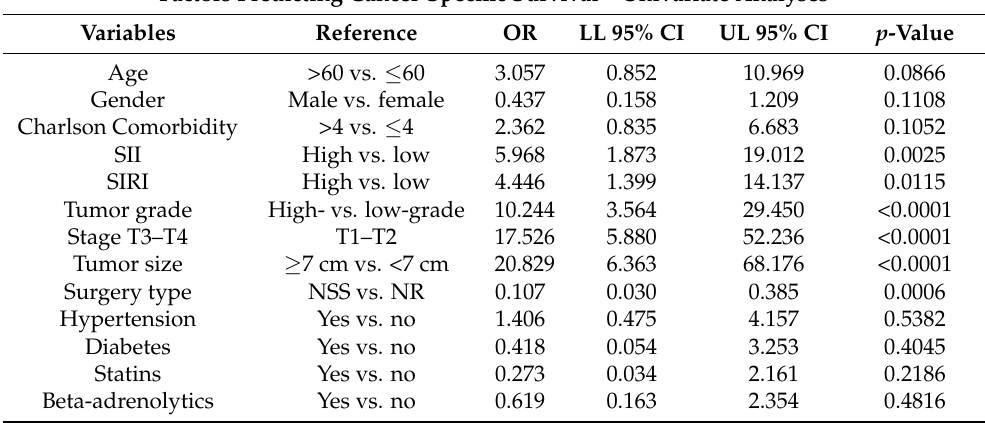
Table 2. Univariate analyses of factors predictive for cancer-specific survival in patients with clear cell renal cell carcinoma (ccRCC).